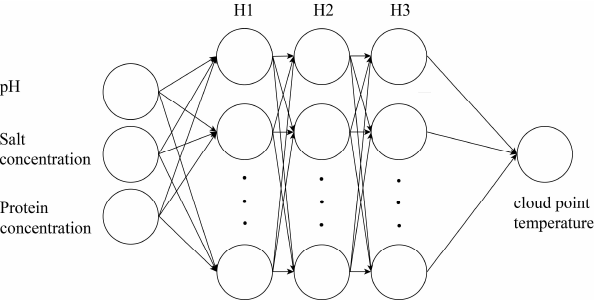
Figure 2. The recurrent neural network model with three hidden